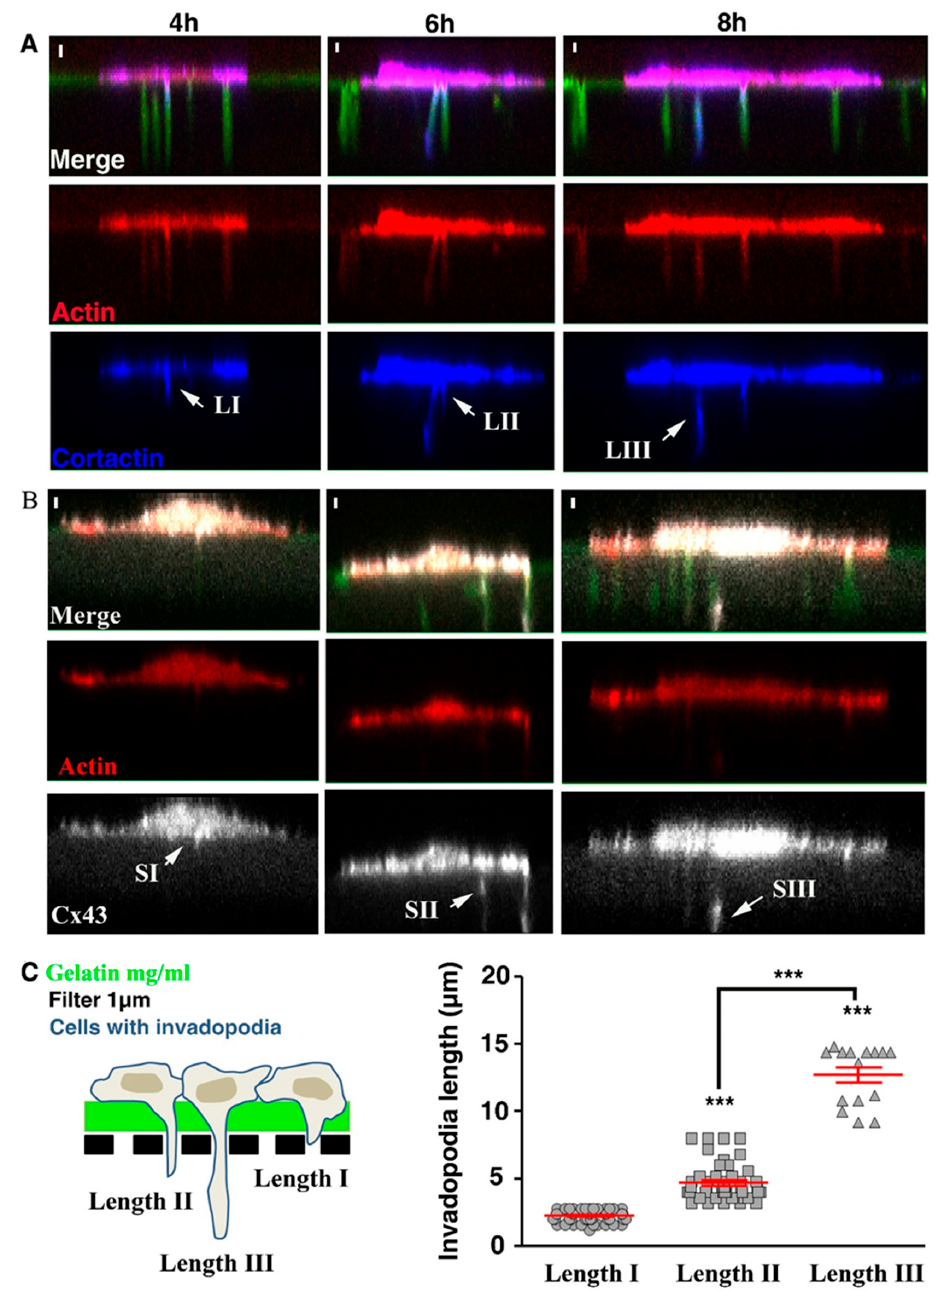
Figure 3. Cx43 is localized in invadopodia during their fomation and maturation. ( A , B ) Cells were cultured (1 × 10 4 cells/mL) on inserts (1 µm porosity), coated with FG-gelatin allowing invadopodia formation and maturation. Filters from inserts were observed by confocal microscopy in xz dimension at 4 h (left panel), 6 h (middle panel) or 8 h (right panel) after seeding cells. ( A ) F-actin (Red) and cortactin (Blue) or ( B ) F-actin (Red) and Cx43 (White) were observed by indirect immunofluorescence or using TRITC-phalloidin. Three stages of invadopodia formation and maturation were determined according to invadopodia length and time of culture: Initiation Stage (SI; Length I: LI) at 4 h, Assembly Stage (SII; Length II: LII) at 6 h, and Elongation/Maturation Stage (SIII; Length III: LIII) at 8 h (N = 10) (Scale bar: 2 µm). ( C ) Schematic representation of insert experiment with the three stages of invadopodia formation and maturation on left panel. Right panel represents the observed invadopodia length ( µ m) according to the stages of invadopodia formation and maturation (LI (N = 40): 2.24 ± 0.06 µ m; LII (N = 40): 4.69 ± 0.2 µ m and LIII (N = 15): 12.69 ± 0.56 µ m). *** p < 0.001. Values shown as mean ±